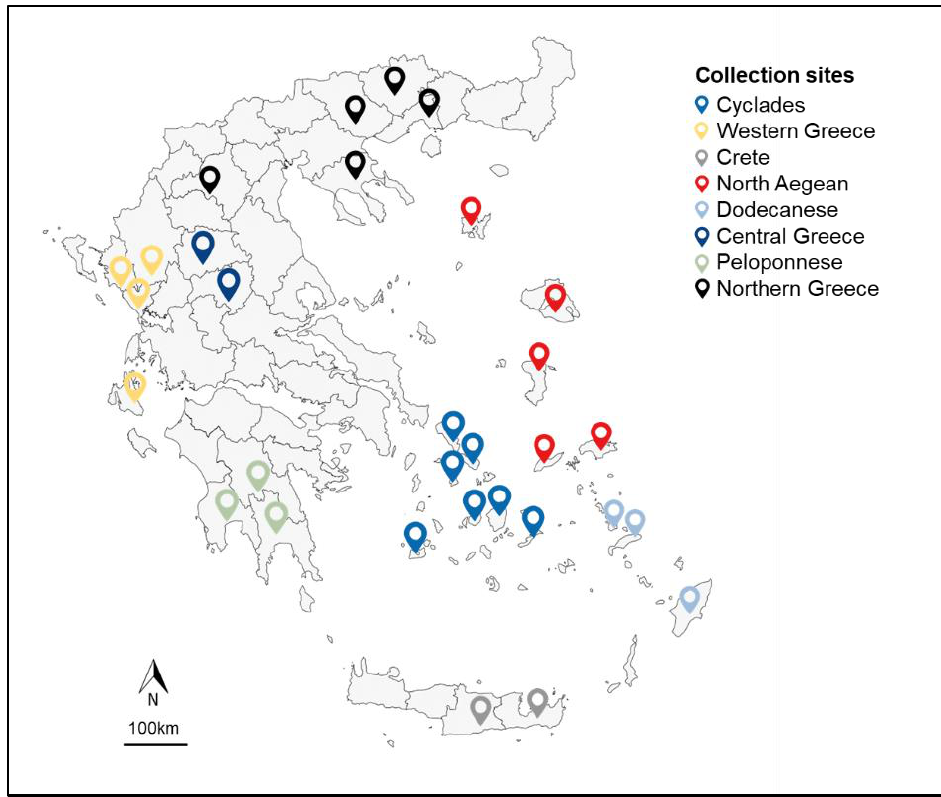
Figure 1. Map of the collection sites of 87 V. unguiculata landraces, grouped in 8 metapopulations as to geographic origin.